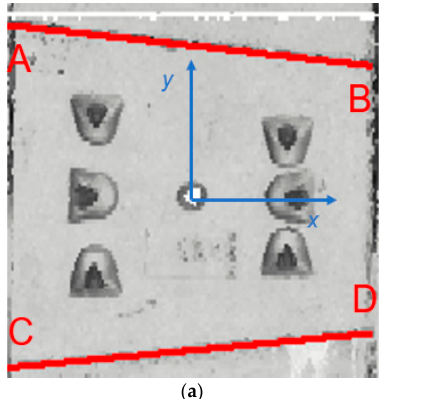
Figure 15. Comparison of longitudinal seams at the same position in the same ring to identify seams of the ( a ) proposed and ( b ) Sun et al.’s method. A, B, C and D are the four corners of the capping block. The x -axis of the coordinate system was parallel to the tunnel centerline and pointed to the direction of large mileage, as shown in Figure 15a. Additionally, the y -axis was perpendicular to the x -axis. The y-coordinate values of the longitudinal seam in the five-ring point cloud were randomly selected and compared with the A, B, C, and D endpoints of the proposed seam positioning method to evaluate its positioning